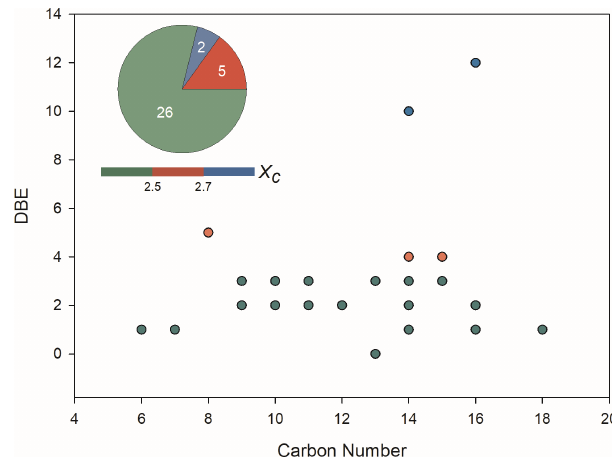
Figure 4. Iso-abundance plot of DBE vs. carbon numbers according to the corresponding aromaticity equivalent (green with X c < 2.5, red with 2.5 ≤ X c < 2.7, and blue with X c ≥ 2.7) for the detected organic sulfur species in the liquid phase, which had also been iden- tified in ambient aerosol